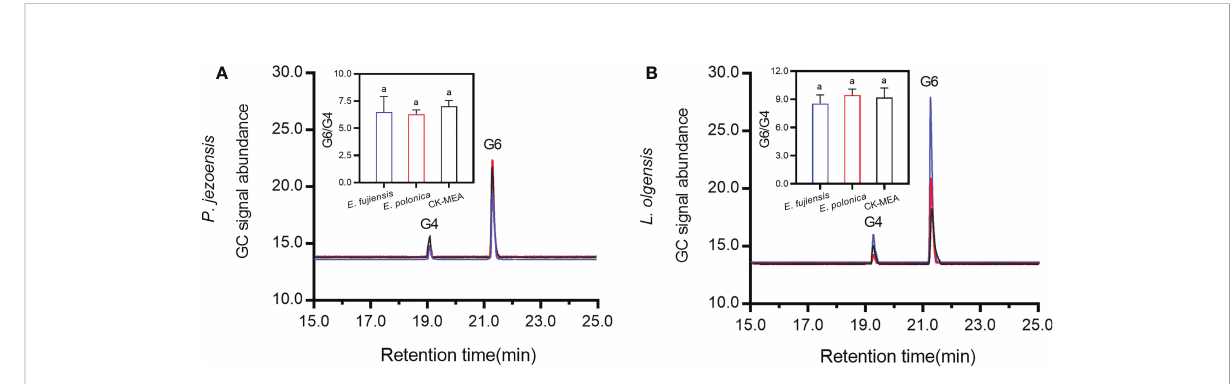
FIGURE 5 Chromatograms of 3,4-dimethoxybenzldehyde (G4) and 3,4-dimethoxybenzoic acid (G6) in P. jezoensis (A) and L. olgensis (B) in response to culture inoculations. Inset plots show the mean (± SE) ratio of peak area of G6 to G4. Different letters in each inset plot indicate signi fi cant differences (Turkey HSD test, a =0.05; n =3 tree replicates per